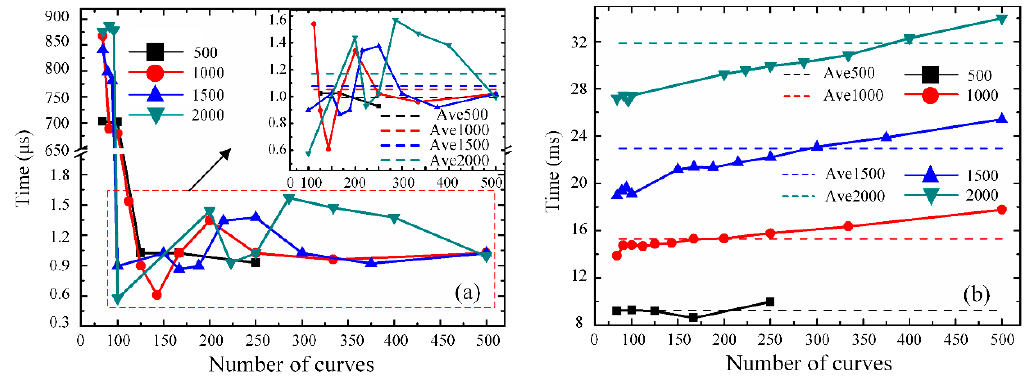
Figure 9. The time consumption comparison results for the differential accumulation processing of single-point vibration positioning between the GPU and CPU: (a) the time spent on GPU (b) the time spent on CPU.